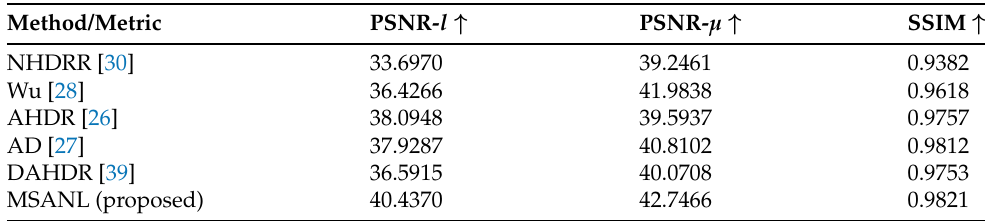
Table 1. Quantitative comparison of the performance of the proposed method (MSANLnet) and state-of-the-art